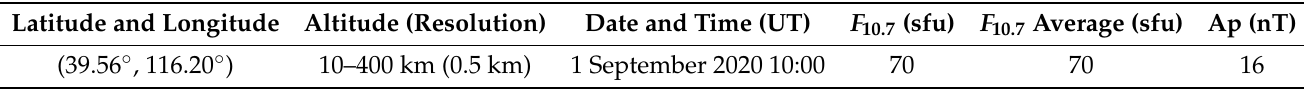
Table 1. The input parameters of NRLMSISE-00 for the calculation of atmospheric density. Latitude and Longitude Altitude (Resolution) Date and Time